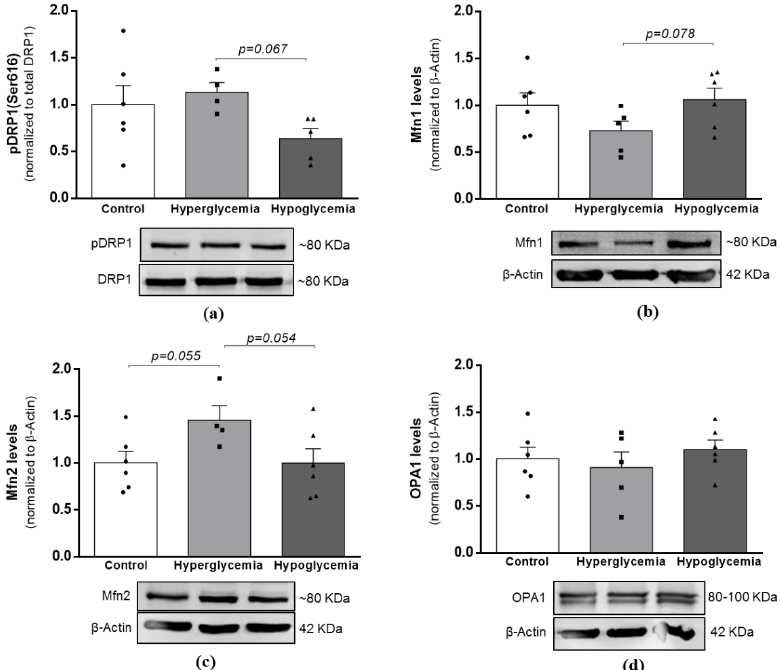
Figure 5. Effects of long-term hyperglycemia and insulin-induced recurrent hypoglycemia on mitochondria dynamics. Western blot analyses of ( a ) pDRP1(Ser616)/DRP1, ( b ) Mfn1, ( c ) Mfn2 and ( d ) OPA1 protein levels. Bars represent the mean ± SEM of the quantification of brain cortical samples from 4-6 rats under each condition after normalization with β-actin levels with respect to control group. Representative immunoblots for each protein and their respective β-Actin results are shown below the graphs (for uncropped images of the Western blots, please see Supplementary Data).